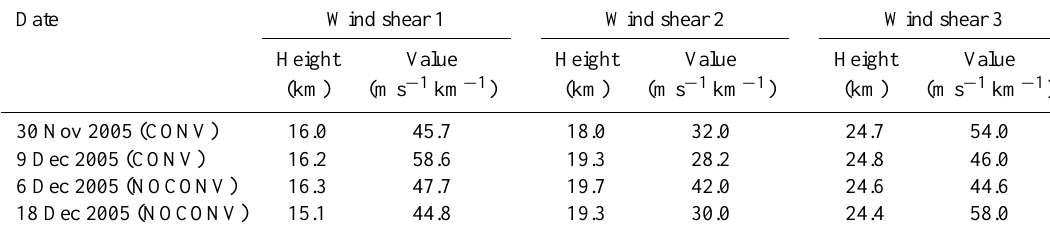
increased from -30 m/s to -33 m/s. While wind speed near 25 km decreased from -35 m/s to -30.4 m/s.